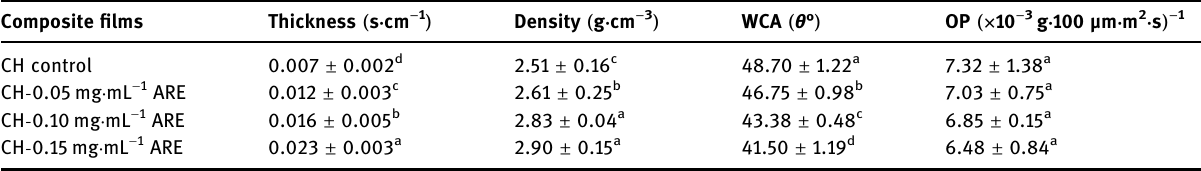
Table 1: Thickness, density, WCA, and OP of CH/ARE composite fi lms containing di ff erent concentrations of ARE Composite fi